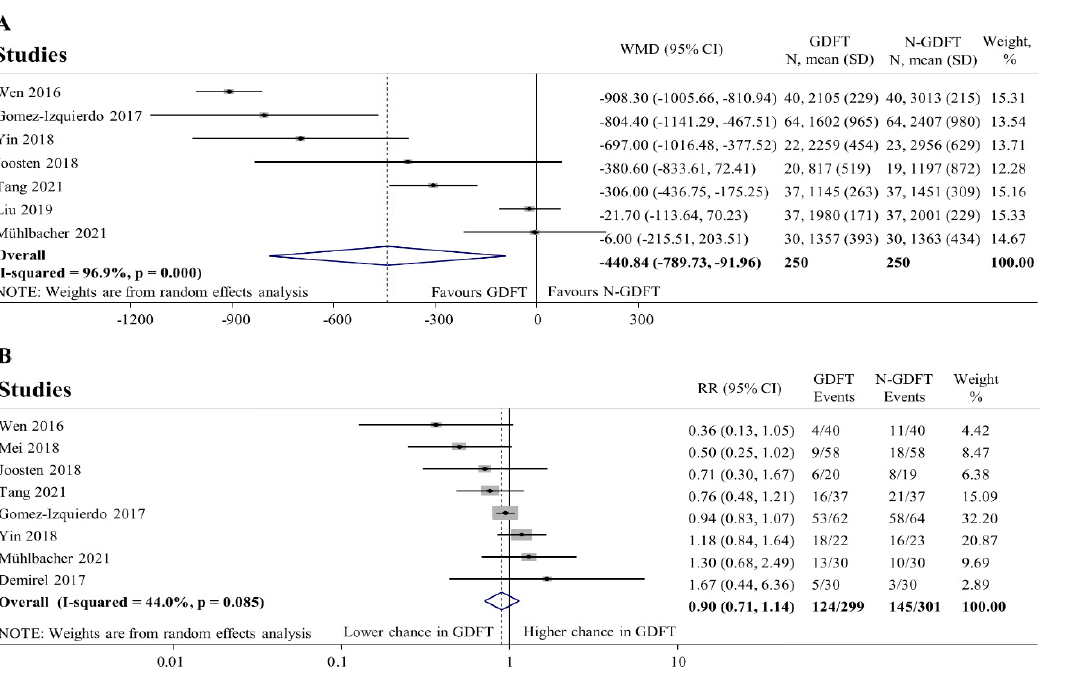
Figure 4. Clinical outcomes at the end of operation. Intraoperative fluid requirement ( A ) was signifi- cantly lower (WMD = − 440.84 mL; 95% CI: − 789.73 mL to − 91.96 mL) in the GDFT group. High heter- ogeneity was detected (I-squared = 96.9%, p < 0.01). There was no significant difference in the number of patients requiring vasopressors intraoperatively ( B ) between the goal- and the non-goal-directed groups. (RR = 0.90; 95% CI = 0.71 to 1.14). Low heterogeneity was found (I-squared = 44.0%; p < 0.01). There was no significant difference in intraoperative urinary output standardised for length of sur- gery (C) between the two groups (SMD = 5.69 mL h − 1 ; 95% CI = − 2.16 mL h − 1 to 13.54 mL h − 1 ). Data were not considered heterogeneous (I-squared = 0.0%; p = 0.96). Serum lactate levels ( D ) were signifi- cantly lower in the GDFT group compared to N-GDFT (WMD = − 0.25 mmol L − 1 ; 95% CI − 0.36 mmol/ to − 0.14 mmol L − 1 ). There is no evidence for heterogeneity (I-squared = 42.7%; p = 0.18). WMD: